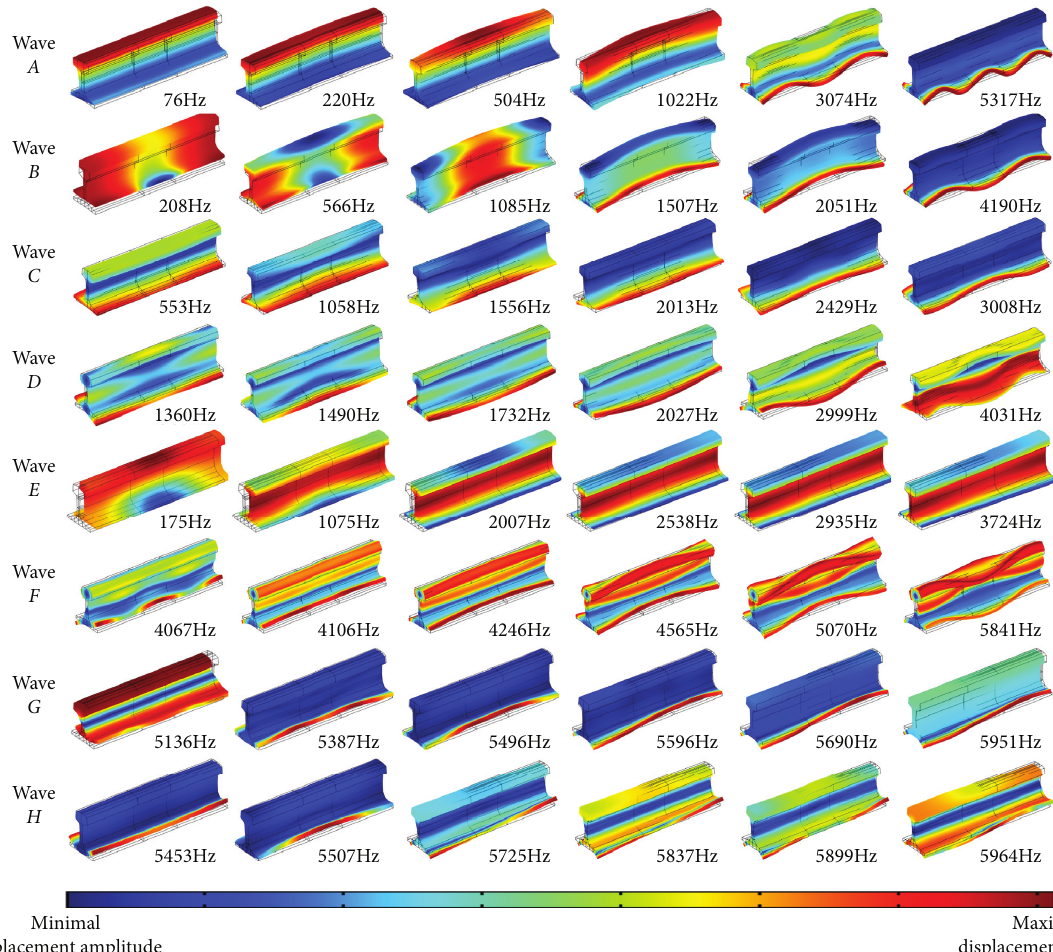
Figure 7: The wave modes of eight propagative waves.